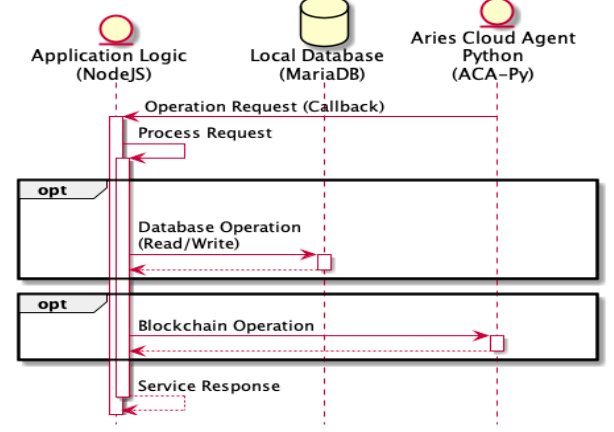
Figure 12. EMSP BC network originated sequence diagram.